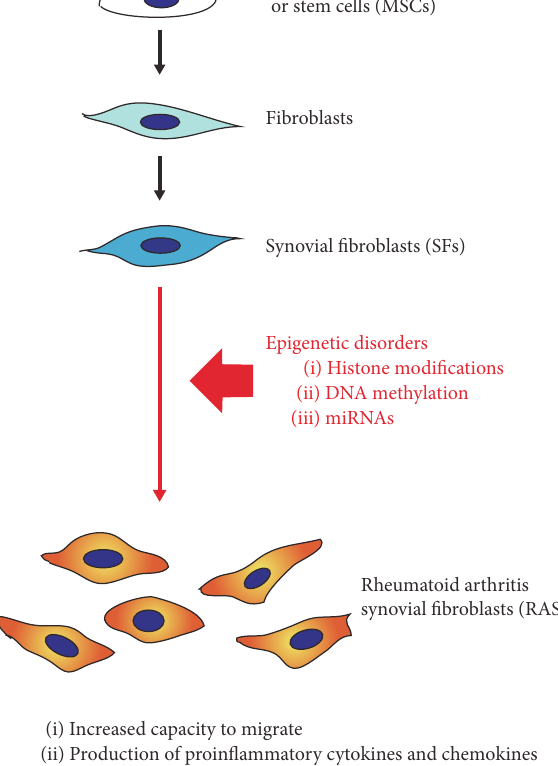
Figure 1: Epigenetic disorders induce the activation of rheumatoid arthritis synovial fibroblasts (RASFs). Normal SFs are differentiated from mesenchymal stromal or stem cells (MSCs) under normal epi- genetic regulation in noninflammatory joints of healthy individuals. The activation of SFs is caused by aberrant epigenetic changes in inflammatory joints of